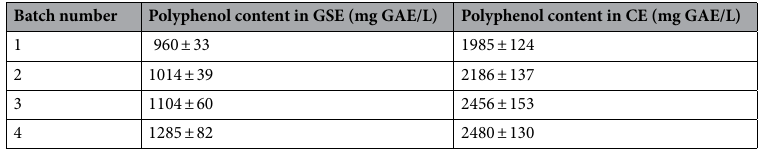
protein concentration from the tissue supernatant was measured by a Nanodrop ND-1000 (Thermo Scientific) and normalized to the same levels. Each sample, containing 50 µg of protein, was separated by SDS–polyacrylamide gel electrophoresis and transferred onto nitrocellulose membranes. The membranes were then blocked with 1% BSA in PBST (3.2 mM